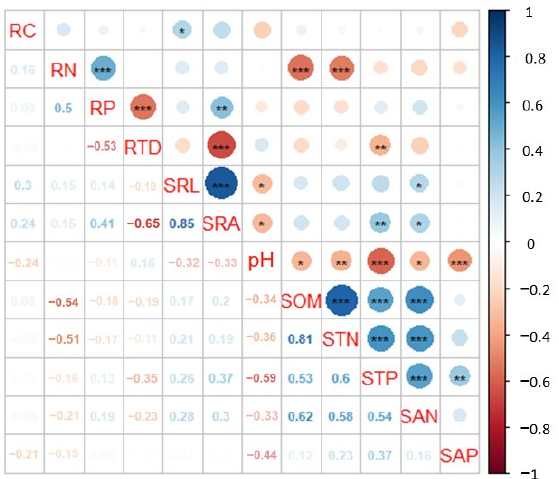
Figure 4. Correlation between fine root functional traits and soil factors (specific root length: SRL;